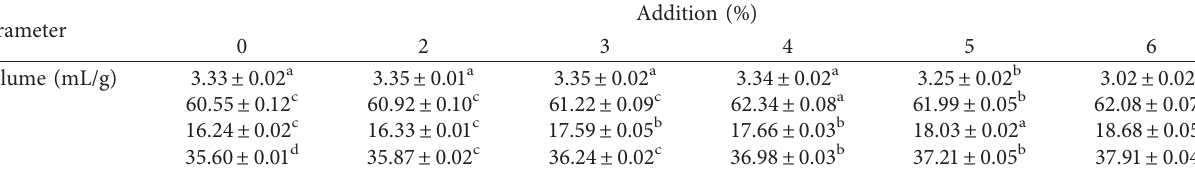
Table 2: The content of free amino acid of bread crumbs (mg/